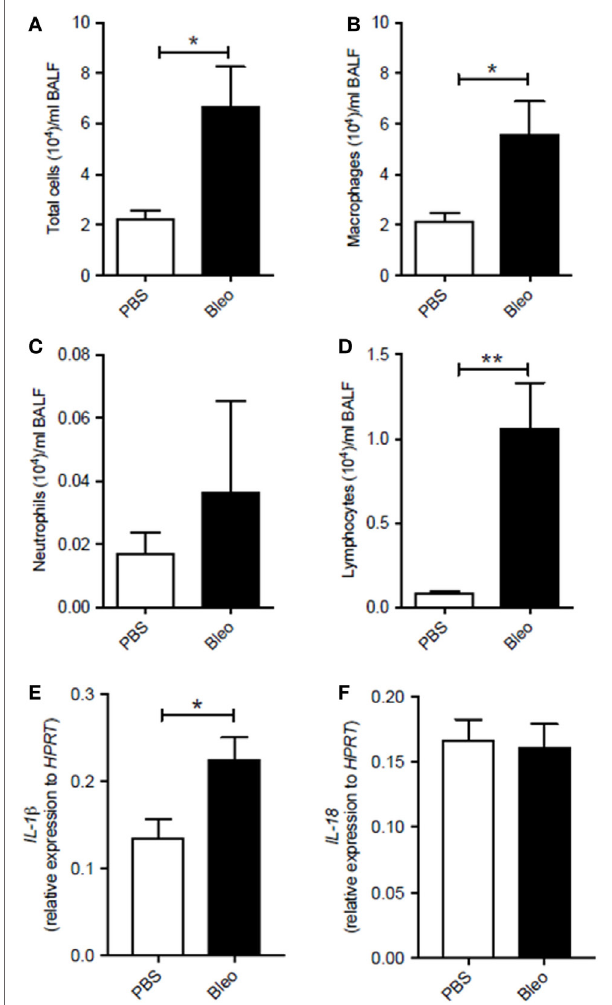
FigUre 1 | Murine lungs of bleomycin-induced fibrosis express higher levels of IL-1 β . Intranasal administration of one dose of bleomycin sulfate (0.05 U/ mouse) to Balb/C mice increased (a) bronchoalveolar lavage fluid (BALF) total cell count ( p = 0.019), (B) macrophages (* p = 0.019), (c) neutrophils ( p = 0.876), and (D) lymphocytes (** p = 0.0095). Analysis of mRNA levels of (e) IL-1 β (* p = 0.0198) and (F) IL-18 ( p = 0.8159) in the whole lung of bleomycin-treated mice. Data are represented as means ± SEM ( n = 4–8). Statistically significant differences were determined by Mann–Whitney test for BALF and unpaired Student’s t -test for mRNA